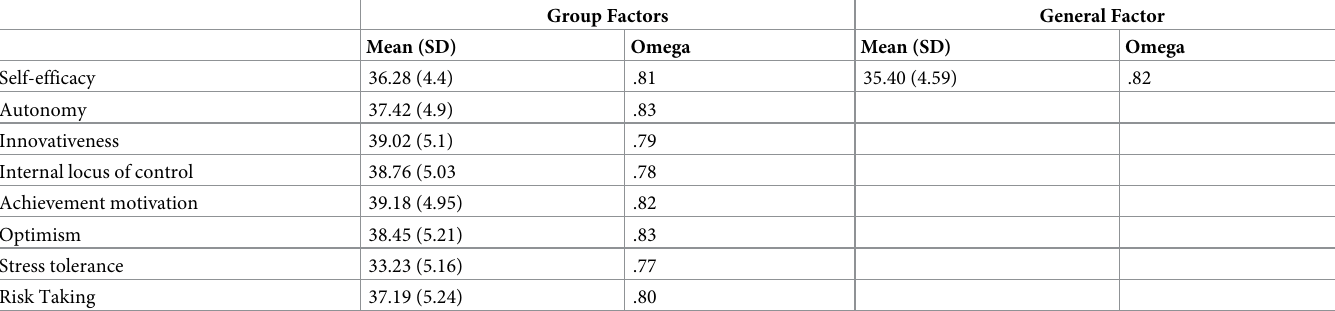
Table 4. Descriptive statistics and internal consistency scores for the BEPE subscales and the general factor.